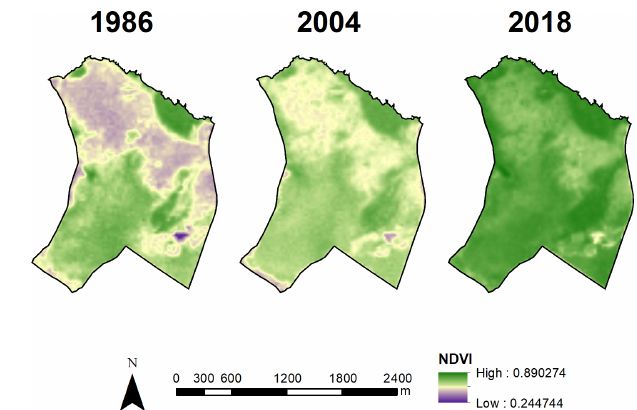
Figure 4. Visual assessment of WPE based on NDVI values of the Panga Ecological Station in 1986, 2004, and